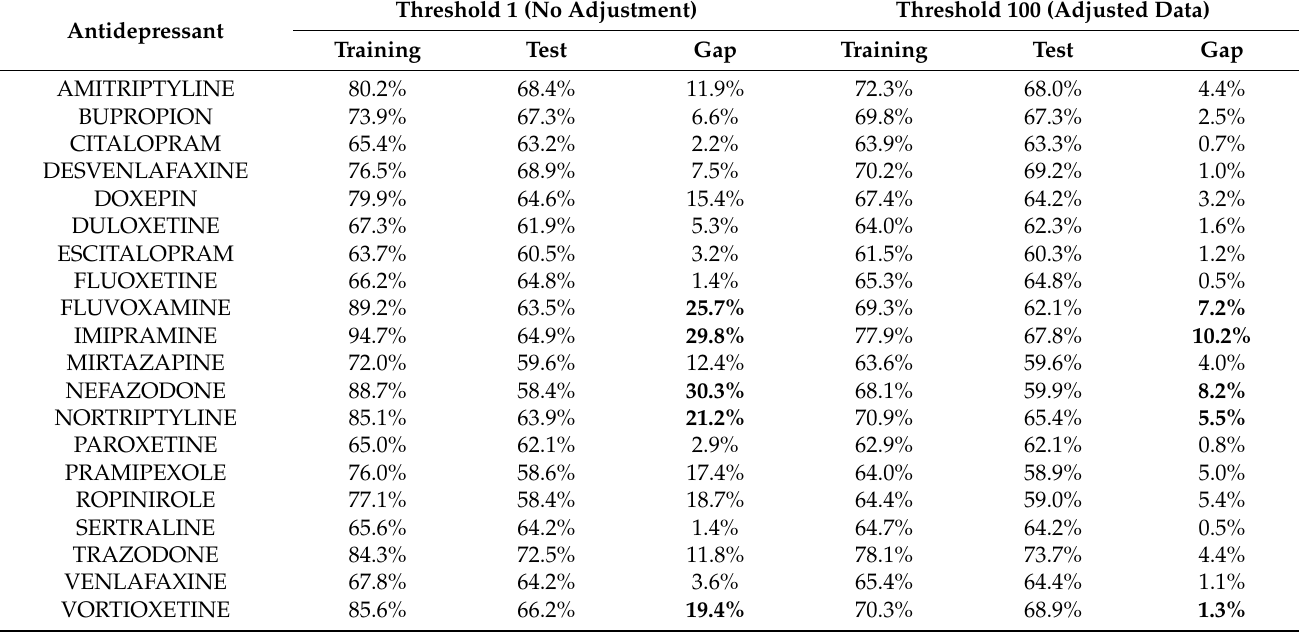
Table 1. AROC gaps for predicted effectiveness between the training and test